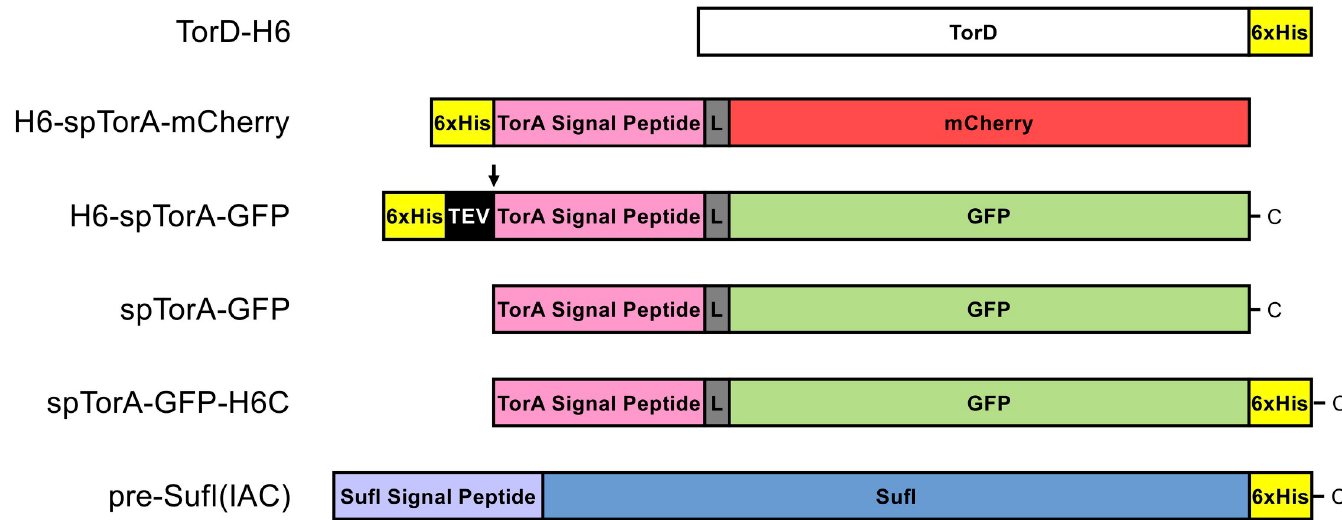
Fig 1. Proteins used in this study. Protein sequences are provided in S1 Fig and plasmid sequences are available from Addgene. A short linker (L) is indicated in gray . The TEV protease cleaves within the TEV recognition sequence (ENLYFQG) between Q and G.